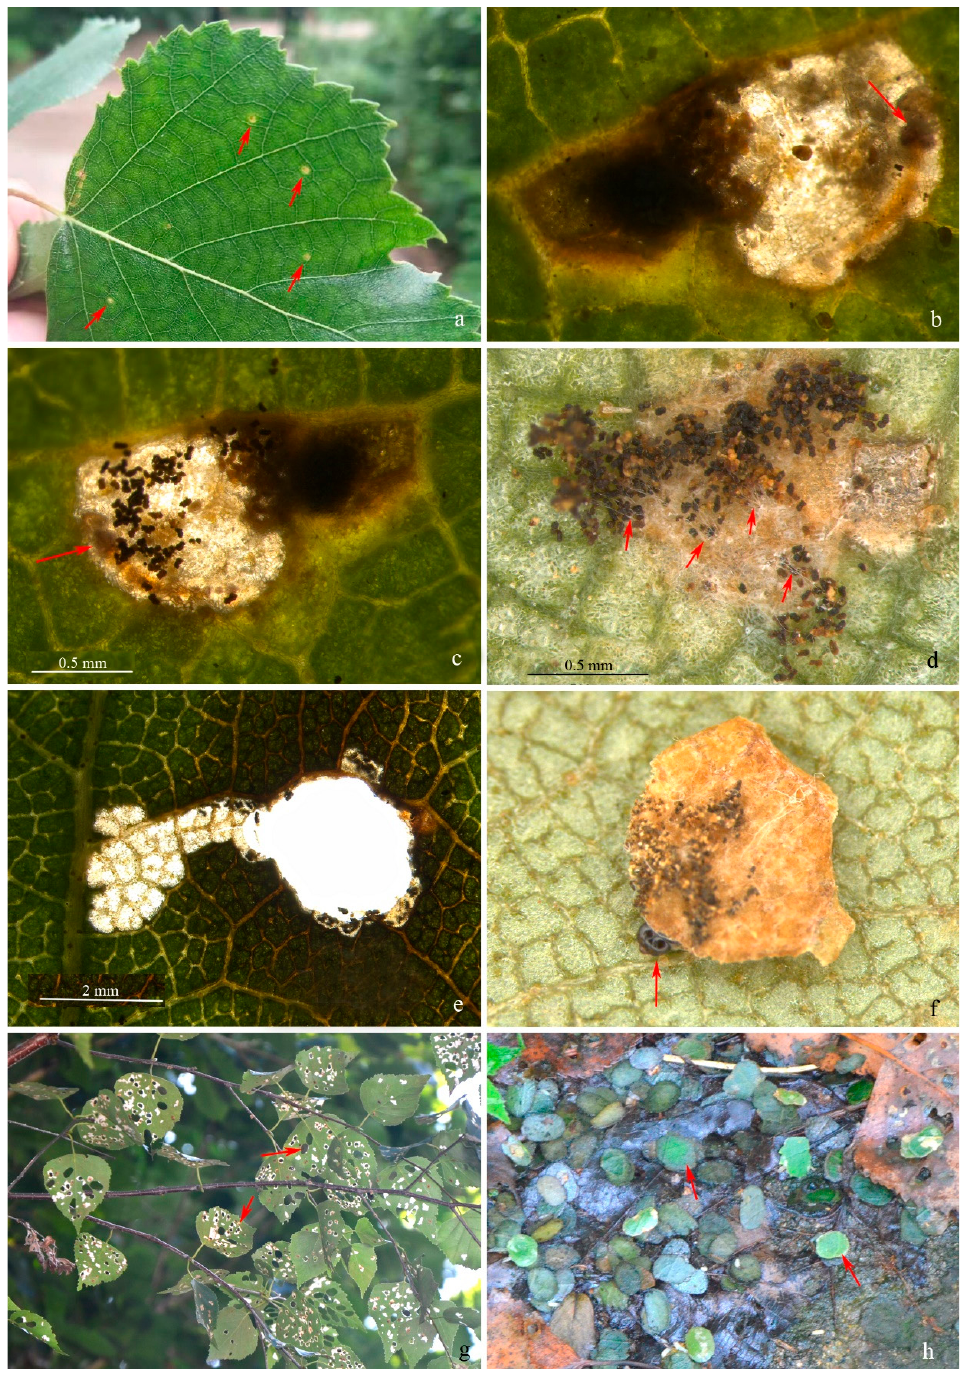
Figure 7. Biology of Subclemensia taigae . ( a ) Leaf mines of first-instar larvae as indicated by red arrows; ( b ) close-up view of early mine from upper side of leaf, arrow indicating head of larva; ( c ) close-up view of early mine from lower side of leaf, arrow indicating head of larva; ( d ) fecal pellets attached on lower surface of the mine with silk threads, arrows indicating the silk threads; ( e ) a hole on the leaf created by first-instar larva in case; ( f ) a single-layered portable case, arrow indicating the head of the larva; ( g ) damage by the larvae, arrows indicating the holes on leaves; ( h ) portable cases on the ground searching for overwintering place, arrows indicating two of the massive cases.